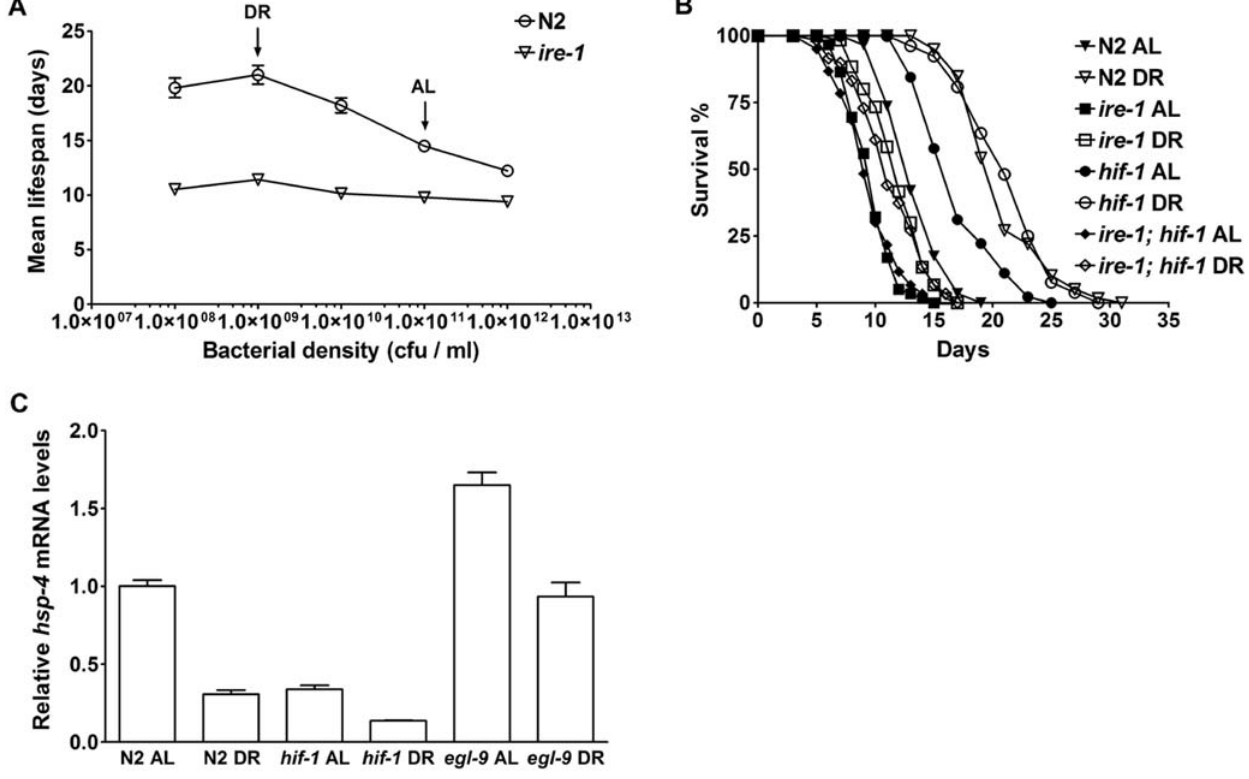
Figure 6. HIF-1 functions through the IRE-1 ER stress pathway to modulate lifespan. (A) IRE-1 modulates lifespan extension by DR. ire- 1(v33) mutant animals show significantly reduced changes in lifespan upon nutrient manipulation. (B) ire-1(v33) fully suppresses lifespan extension by hif-1 under both AL and DR conditions. Each of the lifespan experiments was performed multiple times with consistent results. Quantitative data and statistical analyses for the experiments shown here are included in Table 2 and Table 4. Analyses for the repeated experiments are included in Table S2 and Table S5. (C) hsp-4 mRNA levels are regulated by DR and HIF-1. DR reduces hsp-4 transcription in N2, hif-1 and egl-9 ( p , 0.05, t-test). Overexpression of HIF-1 due to the egl-9(sa307) mutation results in increased hsp-4 transcription under both AL and DR conditions ( p , 0.01, t-test). qRT-PCR experiments were performed twice with consistent results using two independent RNA preparations.